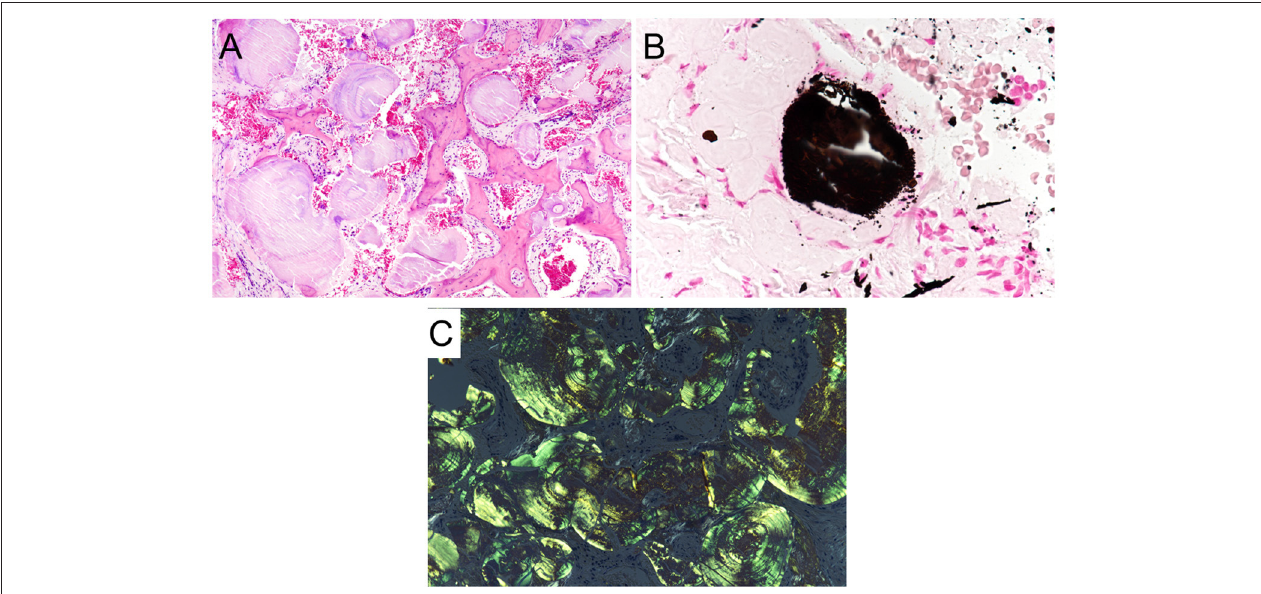
FIGURE 2 | Histopathological features of localized amyloidosis of the nasal mucosa. (A) A histological examination revealed large deposits of amorphous eosinophilic with calcification (H&E staining, × 20). (B) The calcification was stained black (von Kossa staining, × 40). (C) Amyloid depositions with apple-green birefringence were found in the stroma when viewed with polarized light (Congo red staining, ×